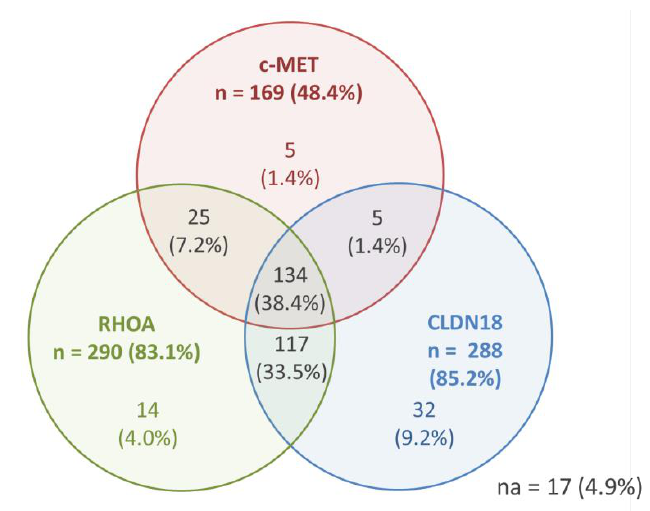
Figure 2. IHC results for c-MET, RhoA, and CLDN18—any positive expression and co-expression ( n = 349 patients).